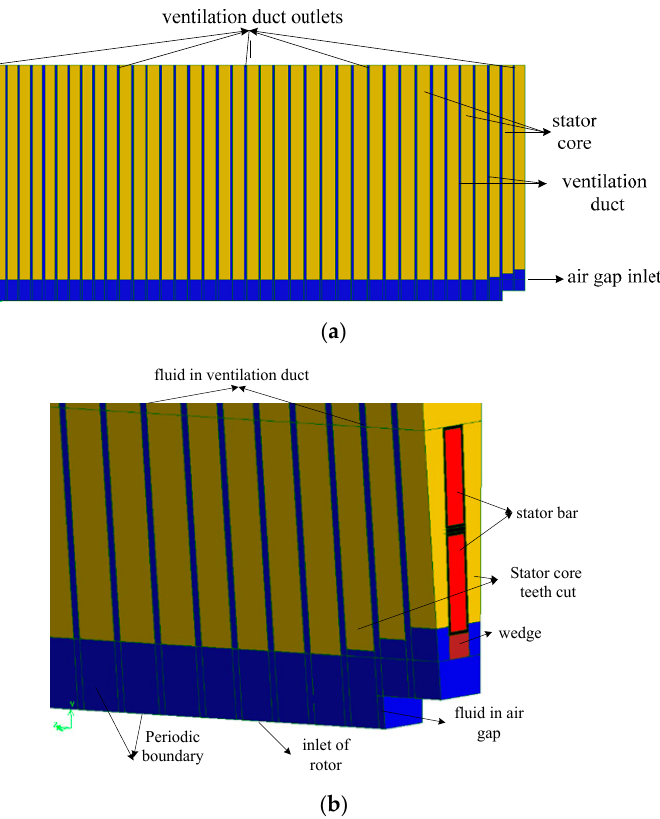
Figure 6. Physical model of stator ventilation system. ( a ) Calculation model of fluid field for 100 MW air-cooled turbo-generator; ( b ) partial display of calculation model.